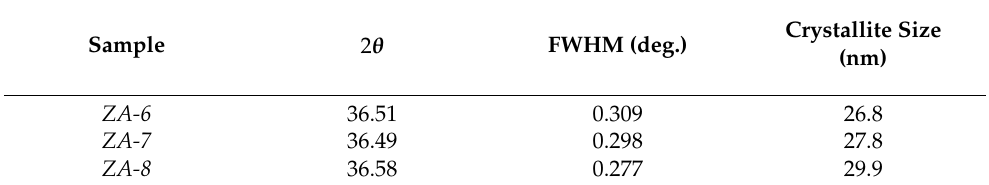
Table 1. In-depth XRD parameters of the prepared Zn(Al)O-MMO Nanorods ( hkl = 101 ) .